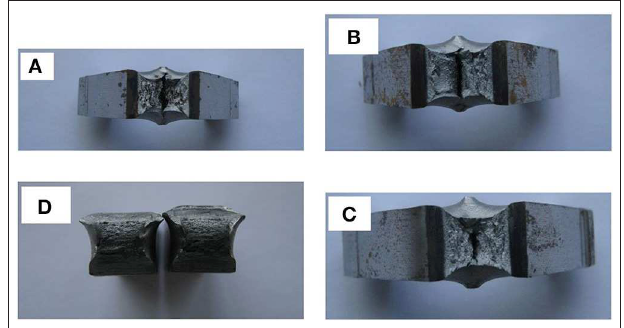
FIGURE 9 | Fracture morphology of FATT (V-notch) at various impact temperatures: (A) − 60 ◦ C, (B) − 20 ◦ C, (C) 0 ◦ C, (D) 20 ◦